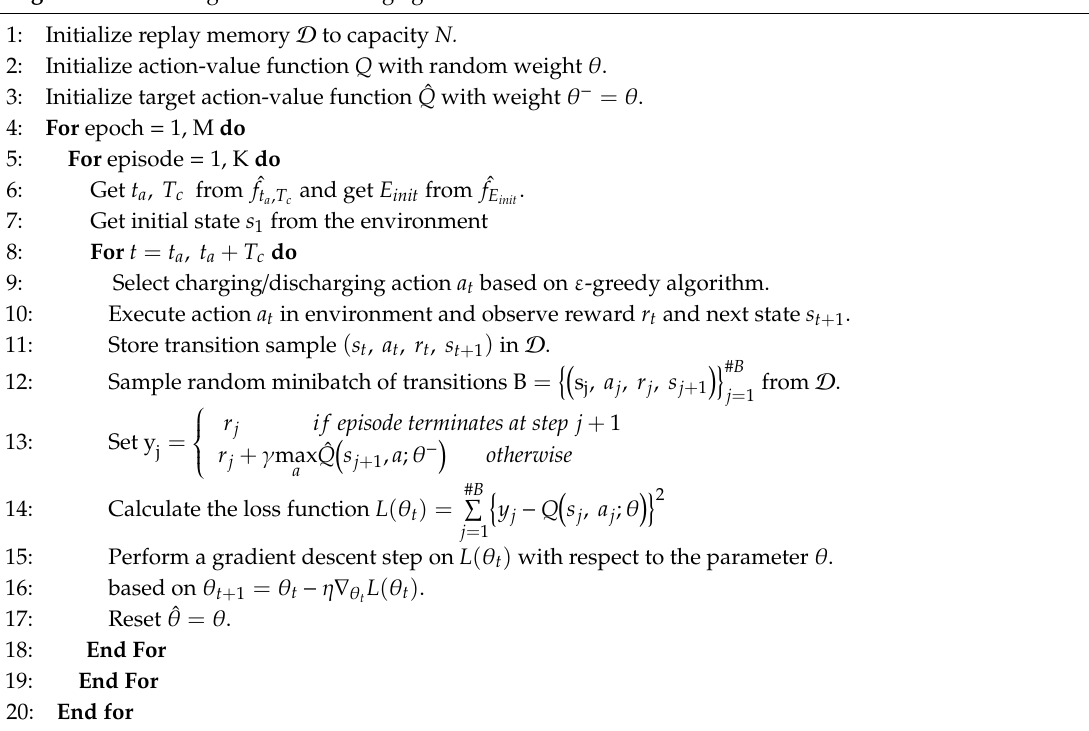
Algorithm 1 Training of EV scheduling